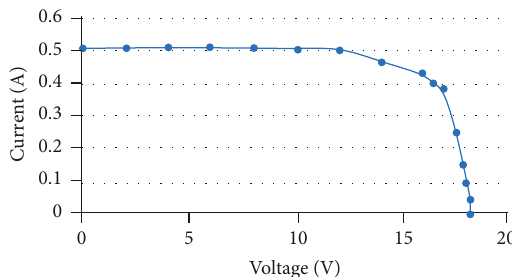
Figure 6: V-I characteristics of monocrystalline lunar panels.